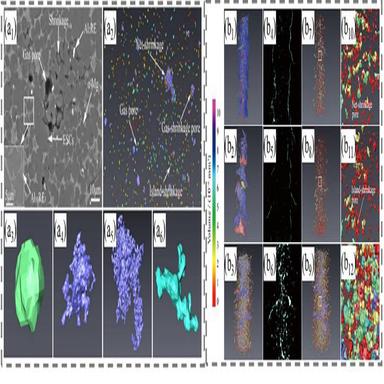
Three-dimensional reconstruction of casting porosity defects under high-pressure die casting: (a1–a6) backscattered scanning image and 3D characterization of pores in HPDC Mg alloy AE44 ; (b1–b12) 3D morphology of specimens corresponding to without ESC collector, with ESC collector .